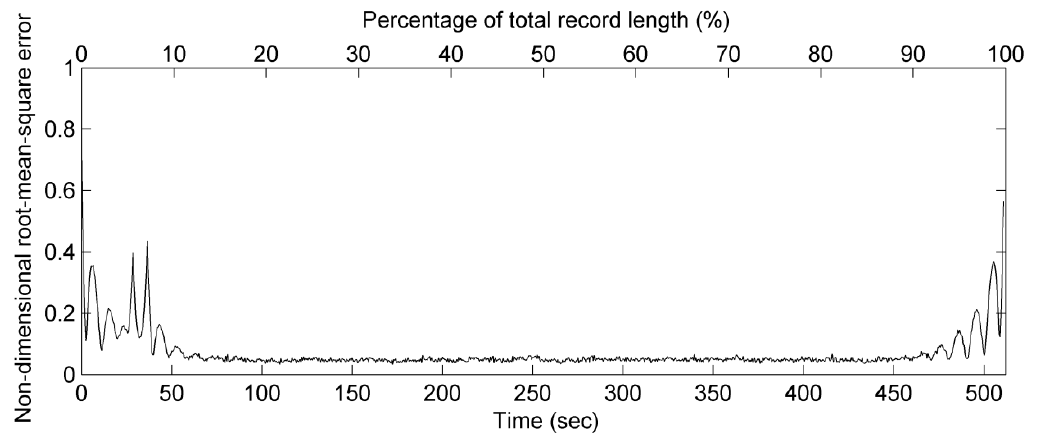
Figure 6. The non-dimensional root-mean-square errors between observational sea surface elevations and synthetic sea surface elevations from 1,500 wave cases. The errors are obvious and unstable at initial and final 70 s durations of a wave